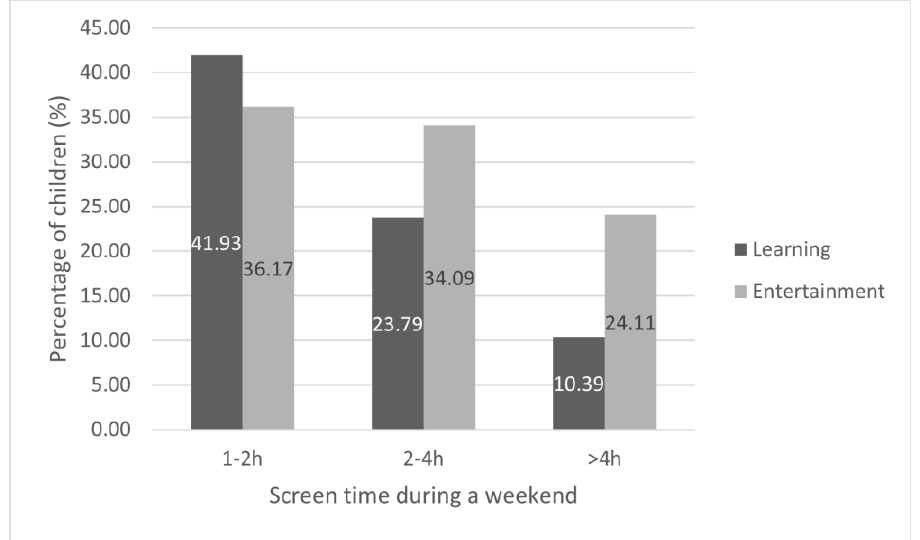
Figure 2. Screen time exposure during a weekend day. Answers of parents who denied that their children were using digital devices for educational (23.89%) or recreational (5.56%) purposes are not presented. Table 2. Screen time in relation to the age of children.